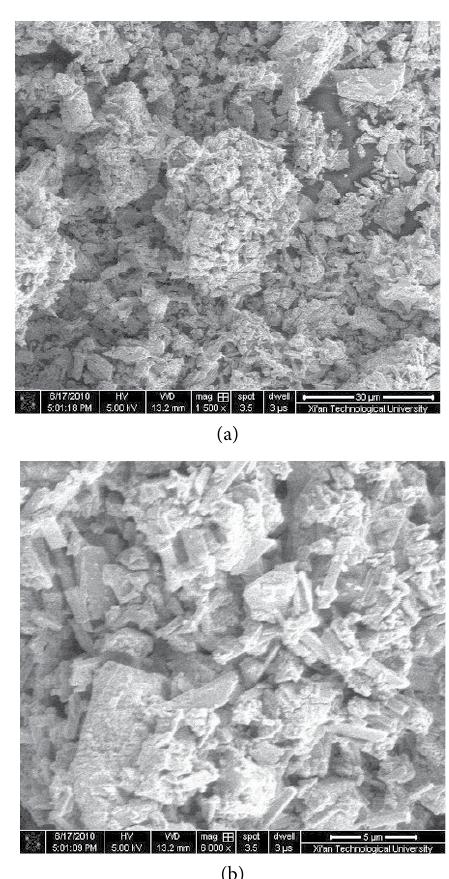
Figure 5: SEM images of the NiZrMo: low magnification and high